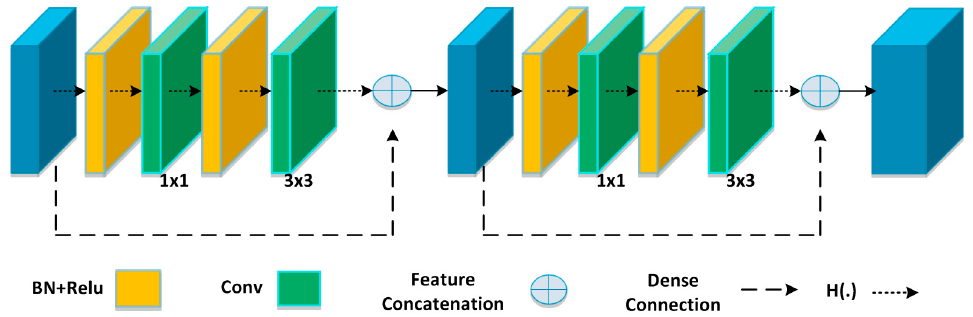
Figure 3. DenseNet–architecture . Figure 3. Table 2. Details of DenseNet-100.